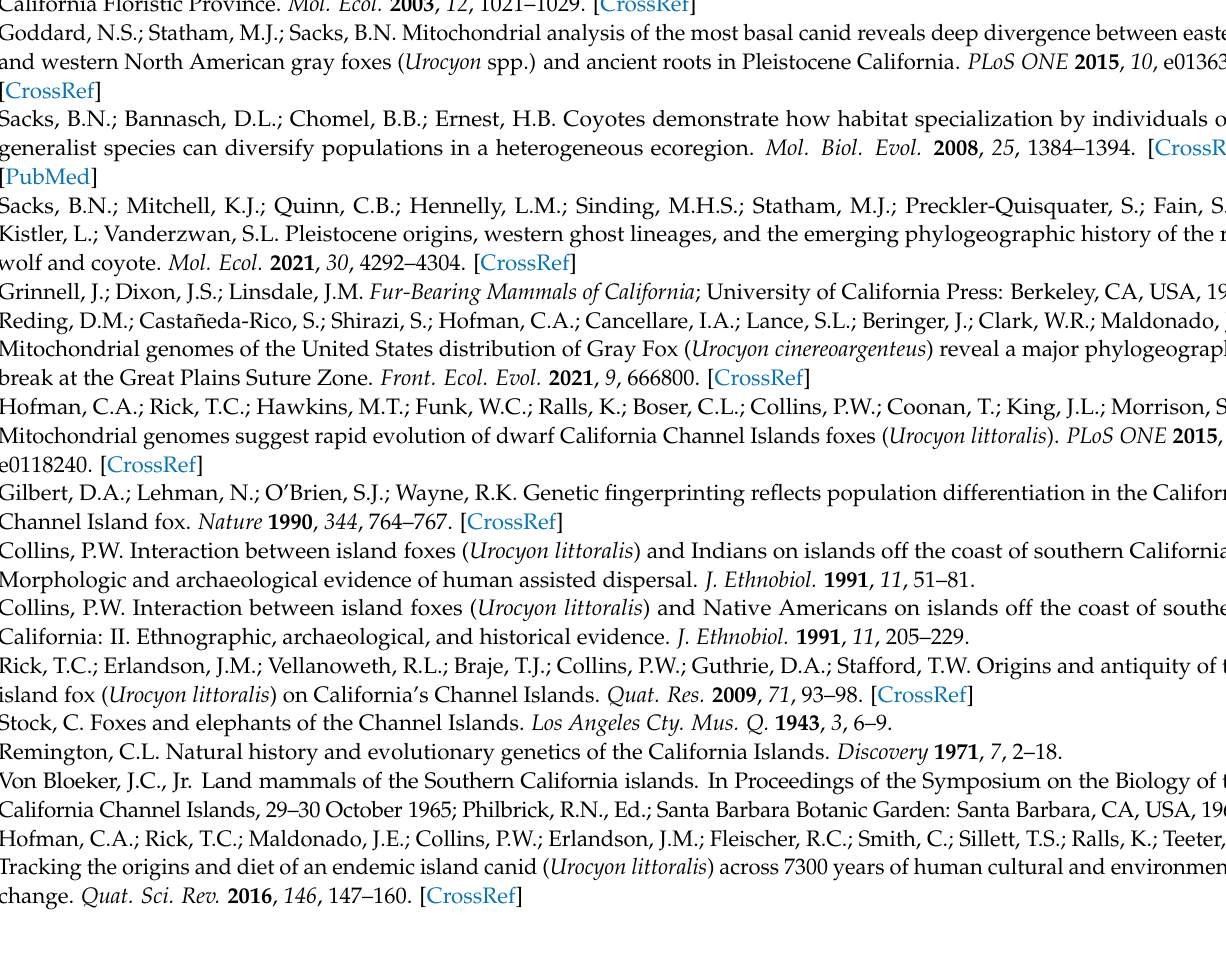
Table S1: List of samples used in study; Table S2: Primer sequences for 20 loci used for gray foxes and island foxes; Table S3: Microsatellite genotypes and Structure cluster assignment for admixture